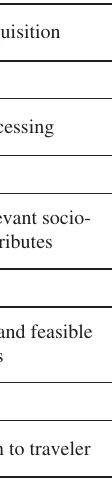
Figure 1: Sequence of Steps Involved in the Proposed Methodology.